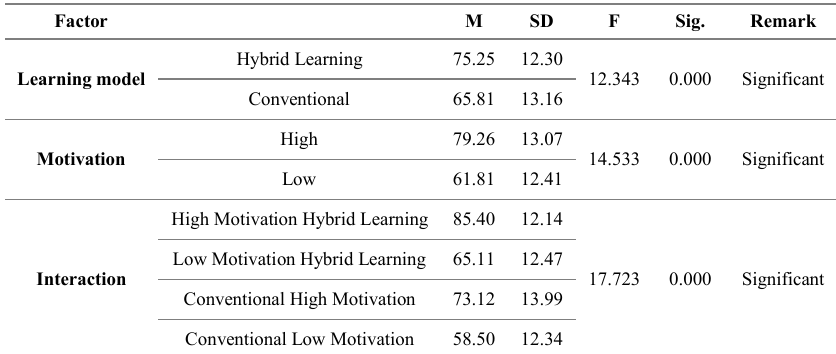
Table 9. MANOVA Test Results against